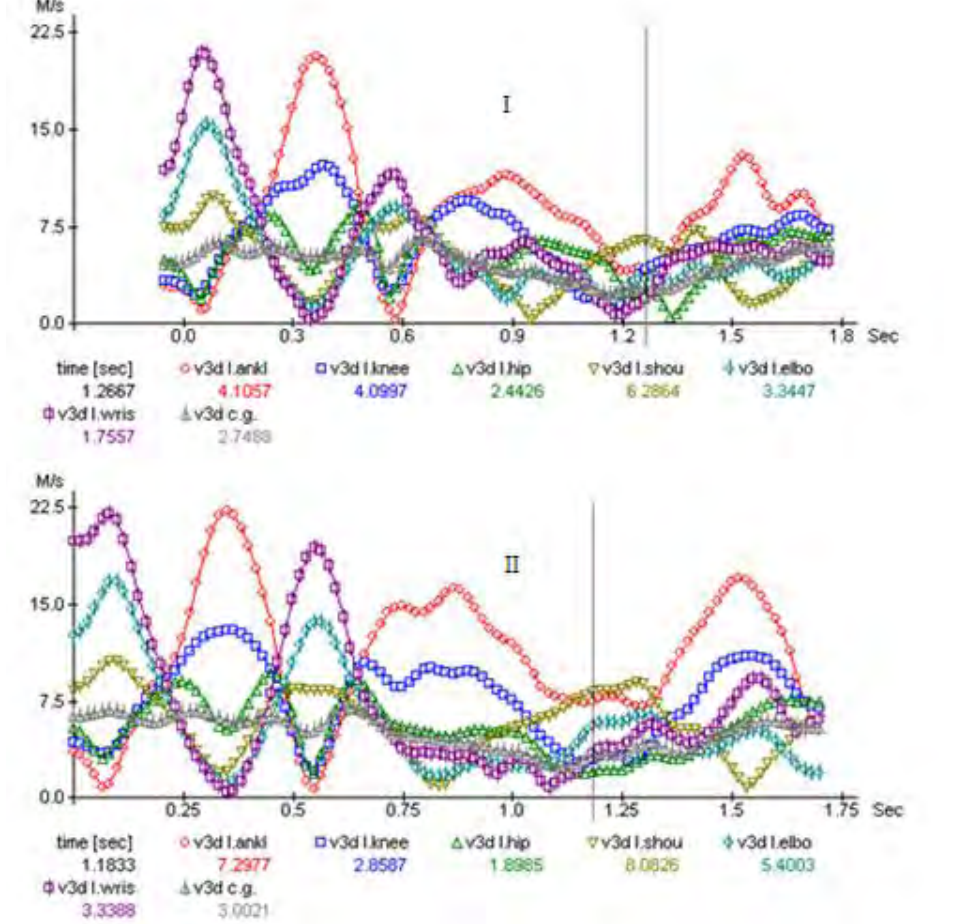
Fig.6. Resultant speed values of ankle, knee, hip, shoulder, elbow and wrist joints, GMC in phase of main movements; MP – passing in second somersault during grouped back double somersault after rondat (tested A, upper section of figure, variant 1, time 1. 266sec.с ) and arched back double somersault after rondat- back turnover (tested B, variant 2, lower section of figure, time 1.